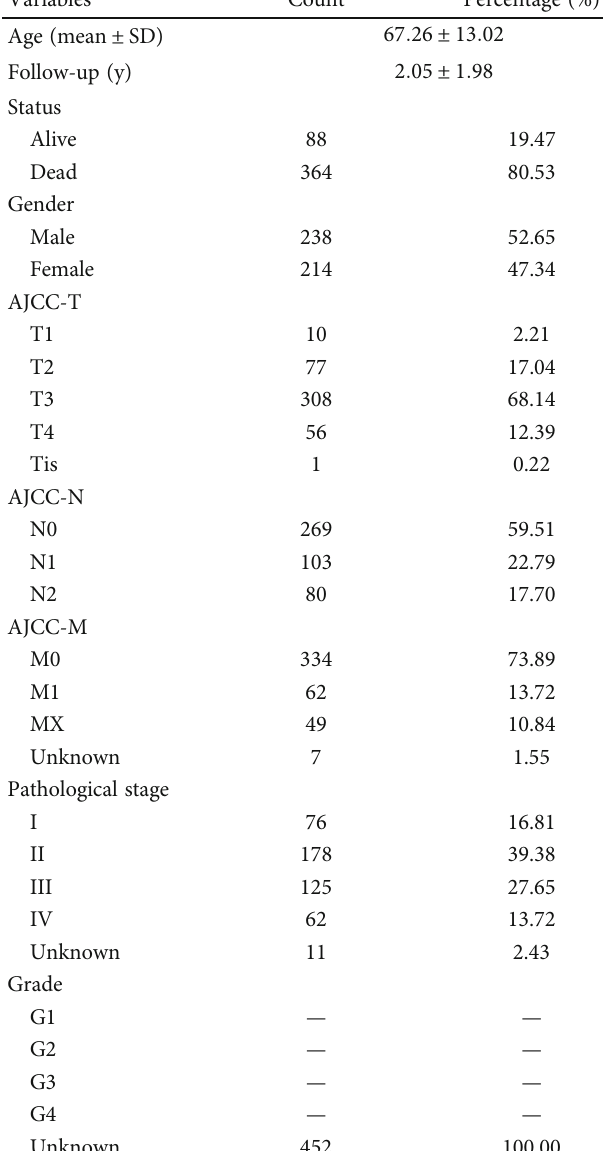
Table 1: Baseline characteristics of 452 CRC patients included in this